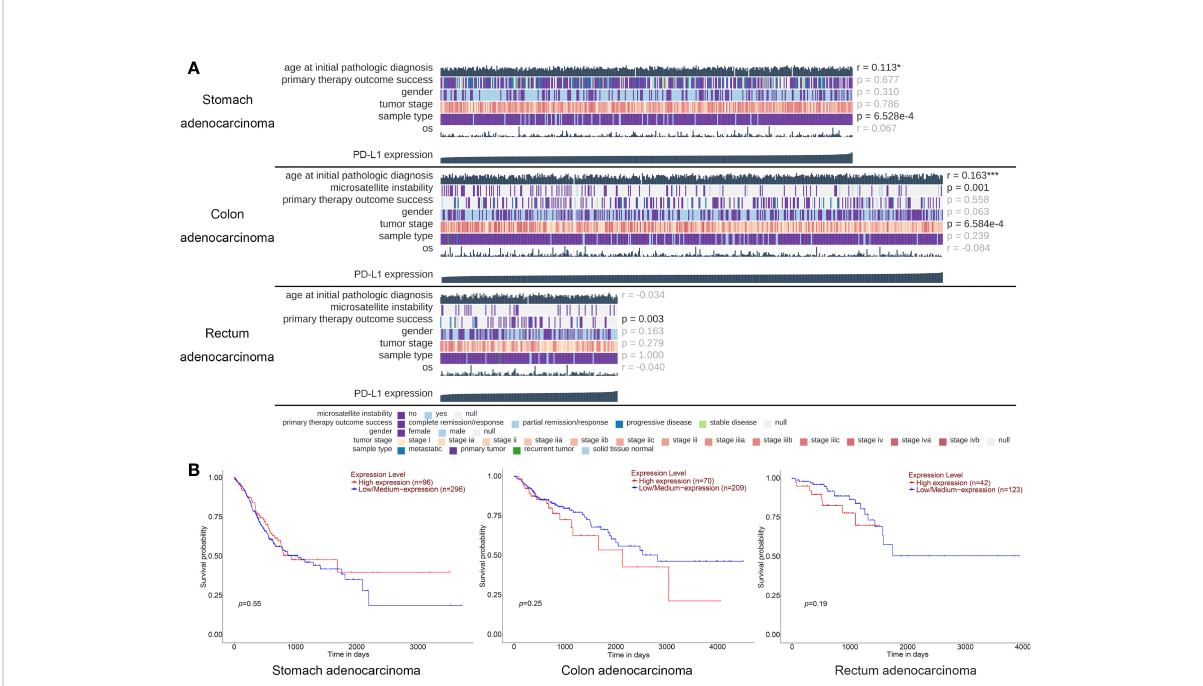
FIGURE 1 TCGA database analysis of the PD-L1 expression and baseline information for patients with gastric cancer. (A) The oncoplots generated on the data of PD-L1 expression and personal baseline in patients with stomach adenocarcinoma, colon adenocarcinoma, and rectum adenocarcinoma, respectively. Each image was generated and analyzed by the MEXPRESS, each column represents a sample, whereas each row represents a different clinical variable. The numbers on the right side of the fi gure show the Benjamini – Hochberg adjusted p-values and Pearson correlation coef fi cients for the comparison between the PD-L1 expression levels and all the other variables. * p < 0.05, *** p < 0.001. (B) The survival curve of different PD-L1 expression level in patients with stomach adenocarcinoma, colon adenocarcinoma, and rectum adenocarcinoma, respectively; each image was generated and analyzed by the